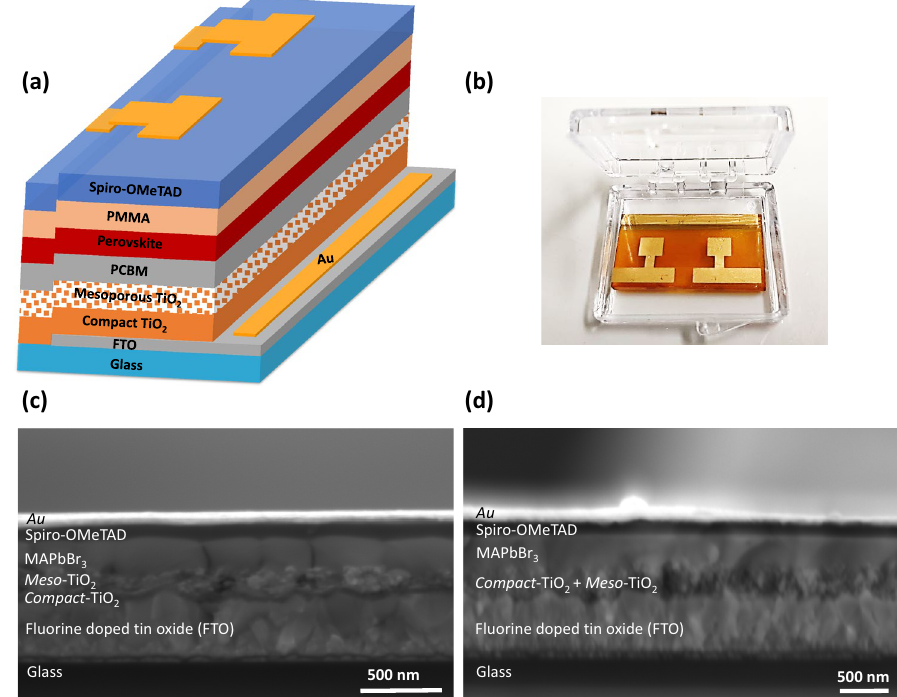
Figure 1. ( a ) Schematic of the device structure, ( b ) Fabricated device (MAPbBr 3 ), ( c ) SEM cross-section of a perovskite solar cell; the MAPbBr 3 layer was deposited by the anti-solvent technique, and ( d ) a FIRA-annealed MAPbBr 3 layer with the structure FTO/c-TiO 2 /meso-TiO 2 /MAPbBr 3